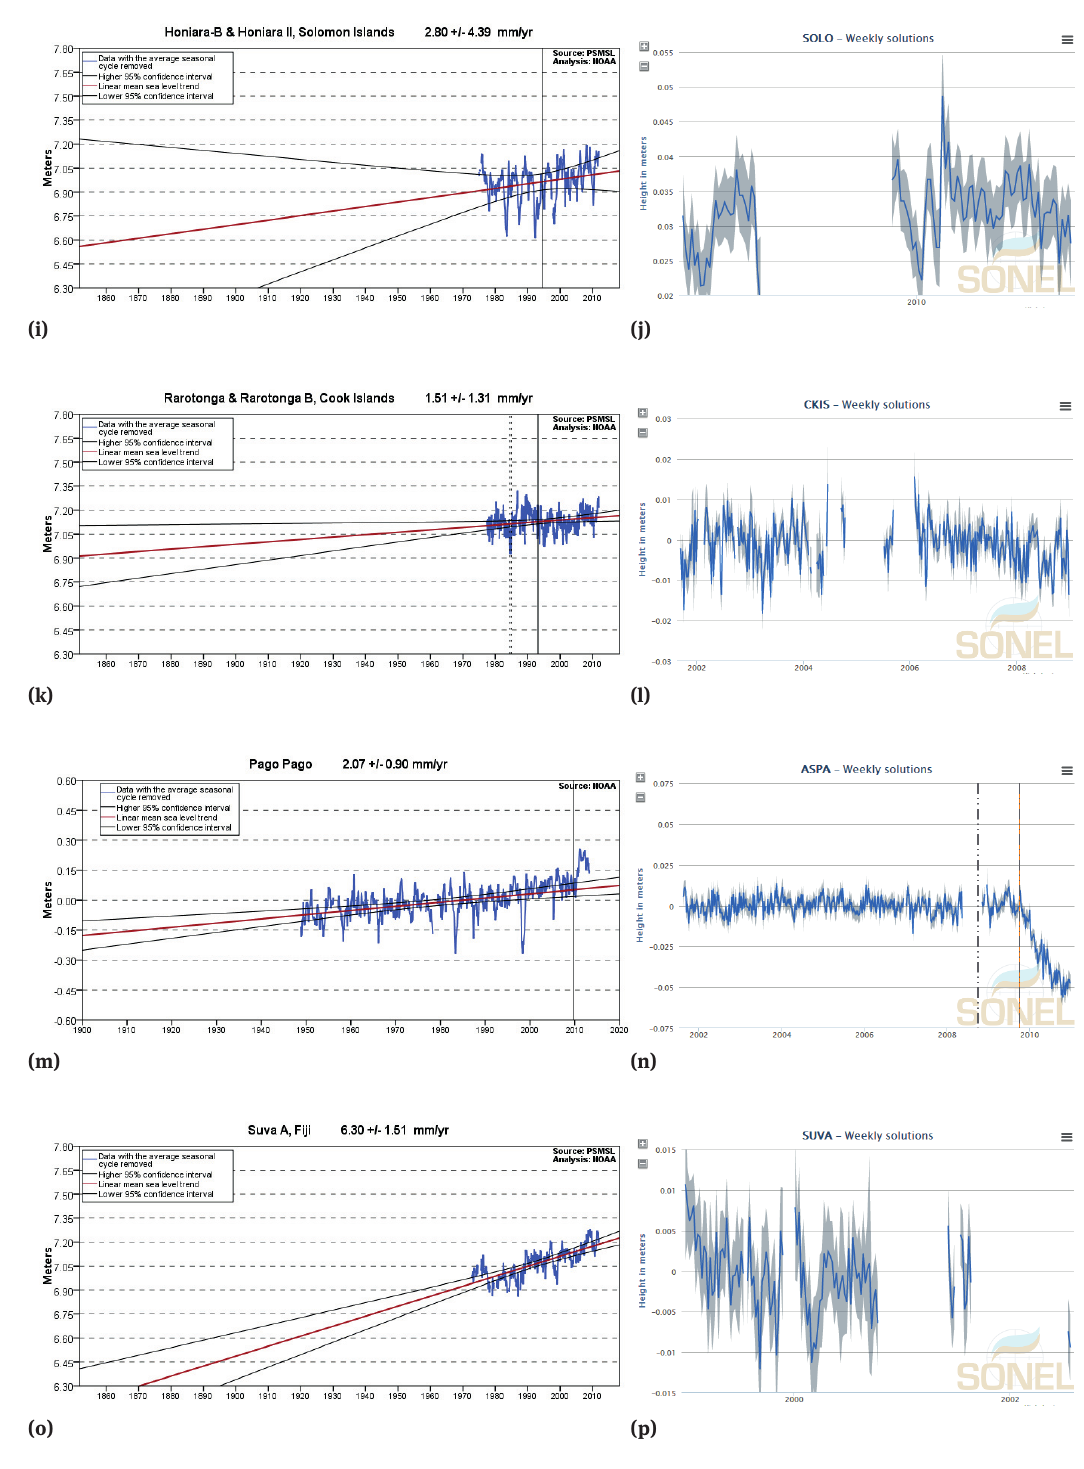
Fig. 3. – continue – Rate of rise of sea level (from [23]) and vertical height of closest GPS station (from [25]) in Western South Pacific is- land locations. The GPS data are scattered data only helpful to detect the presence or absence of a general subsidy for the area of the tide gauge. No conclusive statement can be made about the vertical stability of the tide gauge from these data. The reading of the tide gauge may also be biased upwards or downwards by other factors additional to subsidence or